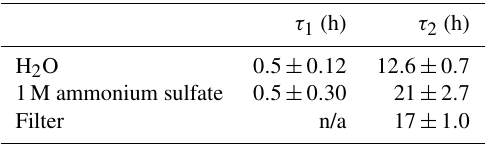
Table 2. Absorbance lifetimes for photobleaching processes de- scribed by Eq. (2) scaled to the 24h average solar actinic flux in Los Angeles. The unscaled measured rate constants are provided in Table S4. Errors represent the standard deviations over the three combined